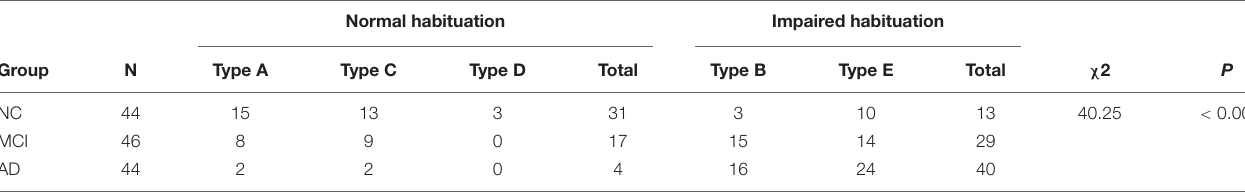
TABLE 3 | Different types of POC activation pattern of the three groups.